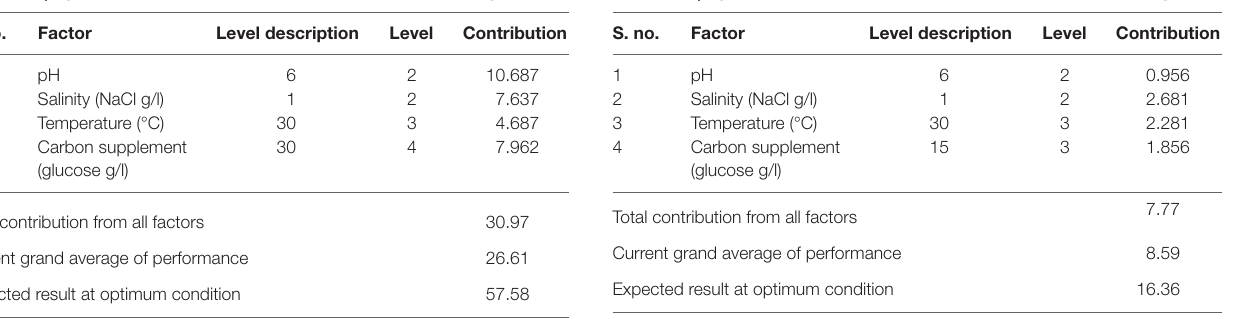
TaBle 10 | Optimum conditions and their contribution on total lipids. TaBle 11 | Optimum conditions and their contribution on neutral lipids.